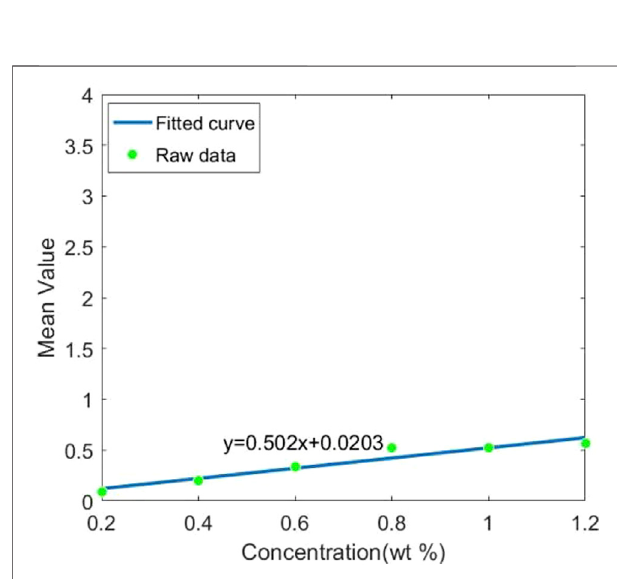
FIGURE 7 | Fluorescence ef fi ciency of